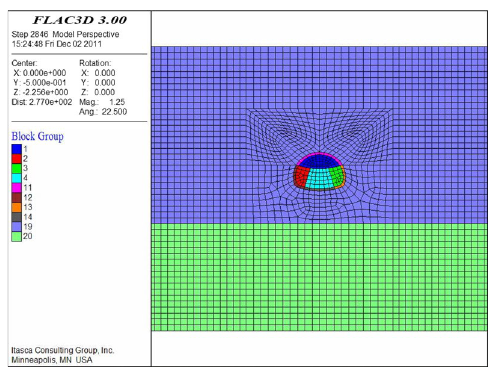
Figure 14. Benching partial excavation method with temporary invert (FLAC3D 3.0 http:// docs. itasc acg. com/ flac3 d700/ flac3d/ docpr oject/ source/ flac3 dhome. html).